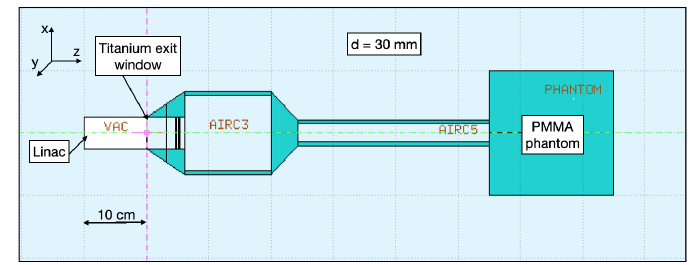
Figure 3. Two-dimensional visualization of FLUKA simulation geometry used for the A-d120 simulation. The beam travels in the z